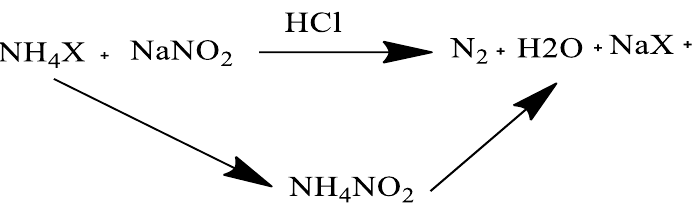
Figure 8. Wax deposition removal using a thermos-chemical process.